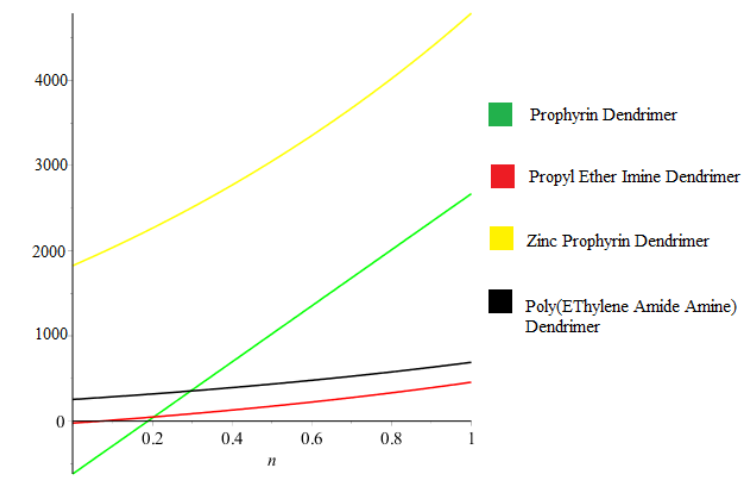
Figure 8. Second reverse hyper-Zagreb